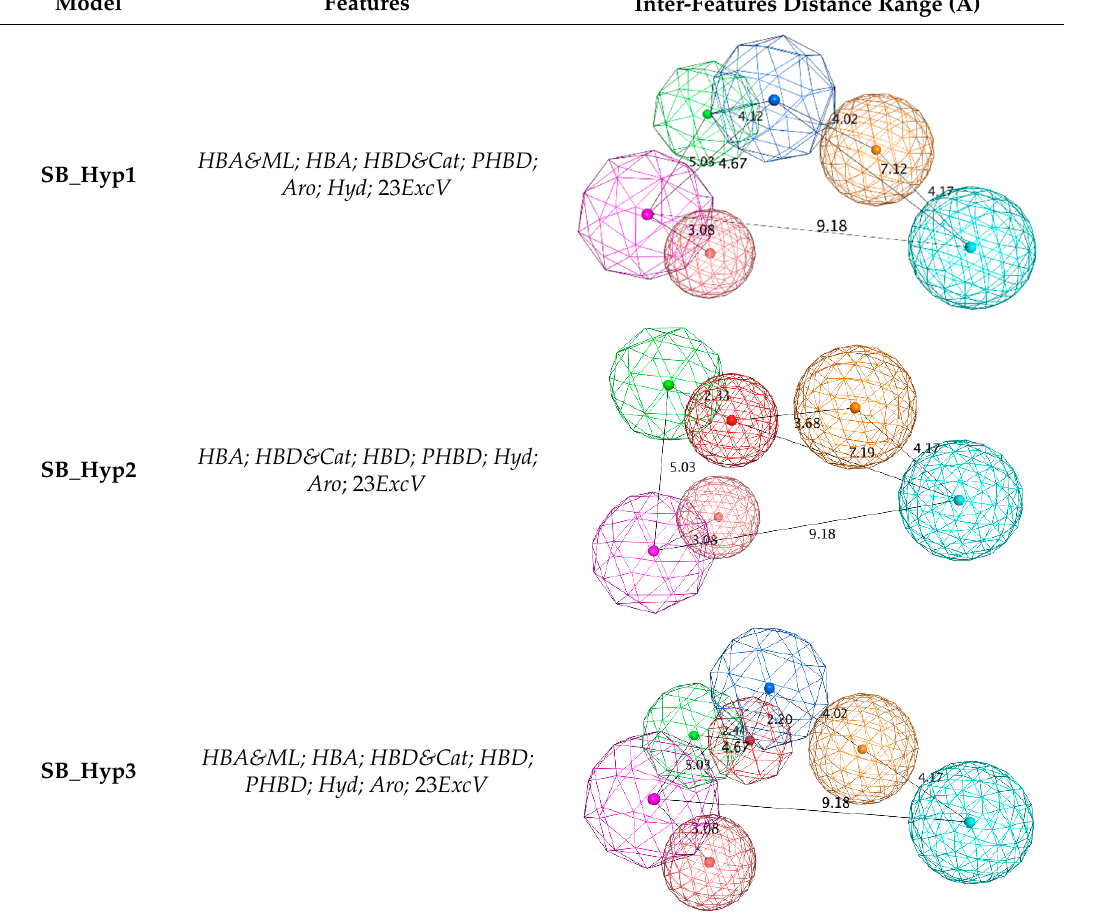
9 of 22 9 of 22